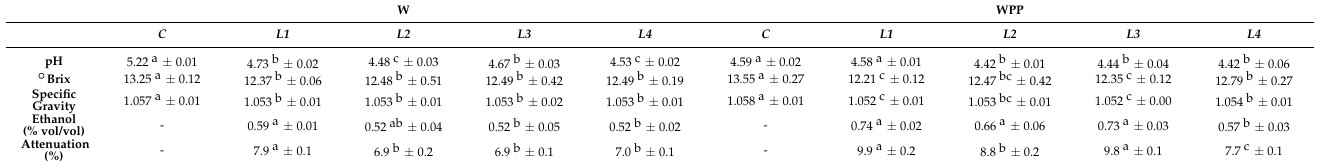
Table 2. Technological parameters determined on malt wort (W) and malt wort added with apricot puree (WPP) before yeast fermentation (C) and after six days of fermentation with Pichia kudriavzevii (L1), Hanseniaspora uvarum (L2), H. pseudoguilliermondii (L3), and H. clermontiae (L4).